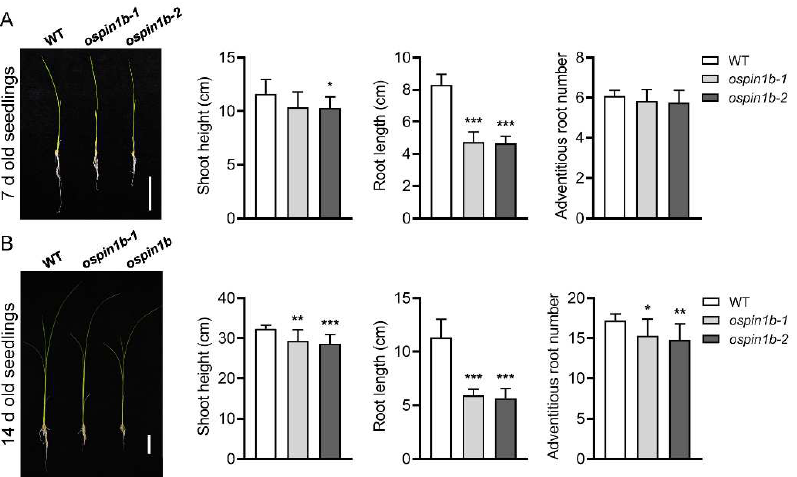
Figure 5. Phenotypes of wild-type (WT), ospin1b-1 and ospin1b-2 seedlings grown in the nutrient solution. ( A ) Phenotypes of 7-day-old seedlings. ( B ) Phenotypes of 14-day-old seedlings. Bar = 4 cm. Values are means ± standard deviation (SD) ( n = 16). Data were analyzed by ANOVA and Tukey’s tests. *: p < 0.05; **: p < 0.01; ***: p <